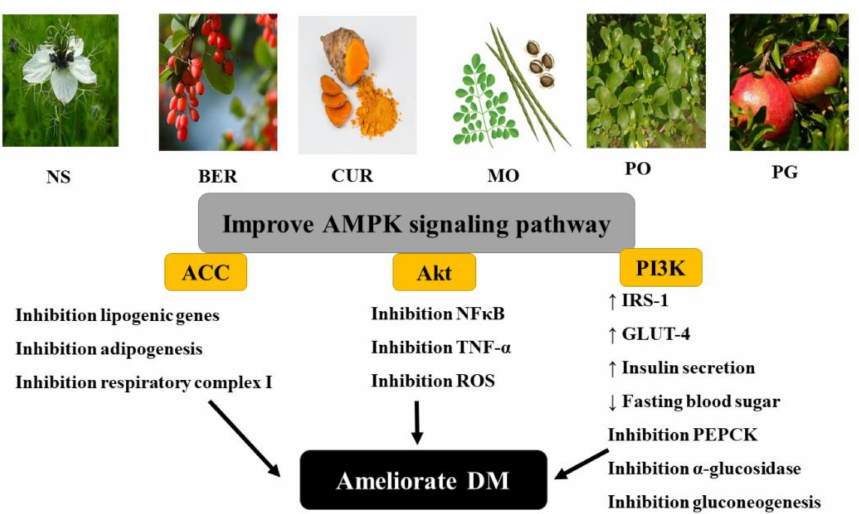
Figure 4. Effect of some natural plants on adenosine monophosphate-activated protein kinase (AMPK) signaling pathway. NS: Nigella sativa , BER: berberine, CUR: curcumin, MO: Moringa olifera